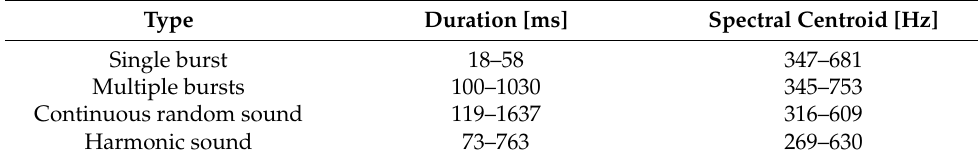
Figure 4. Four common types of bowel sounds: ( a ) single burst, ( b ) multiple bursts, ( c ) continuous random sound, and ( d ) harmonic sound. Reprinted from ref. [135]. Table 2. Time and frequency signatures of different types of bowel sounds. Data from ref.